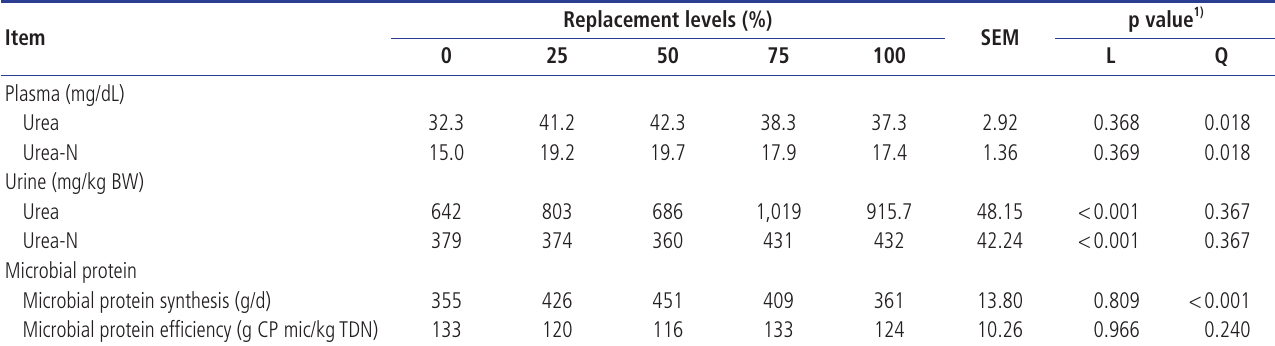
Table 4. Plasmatic concentration, excretion of urea and N-ureic, and microbial protein synthesis for steers fed cactus cladodes plus urea